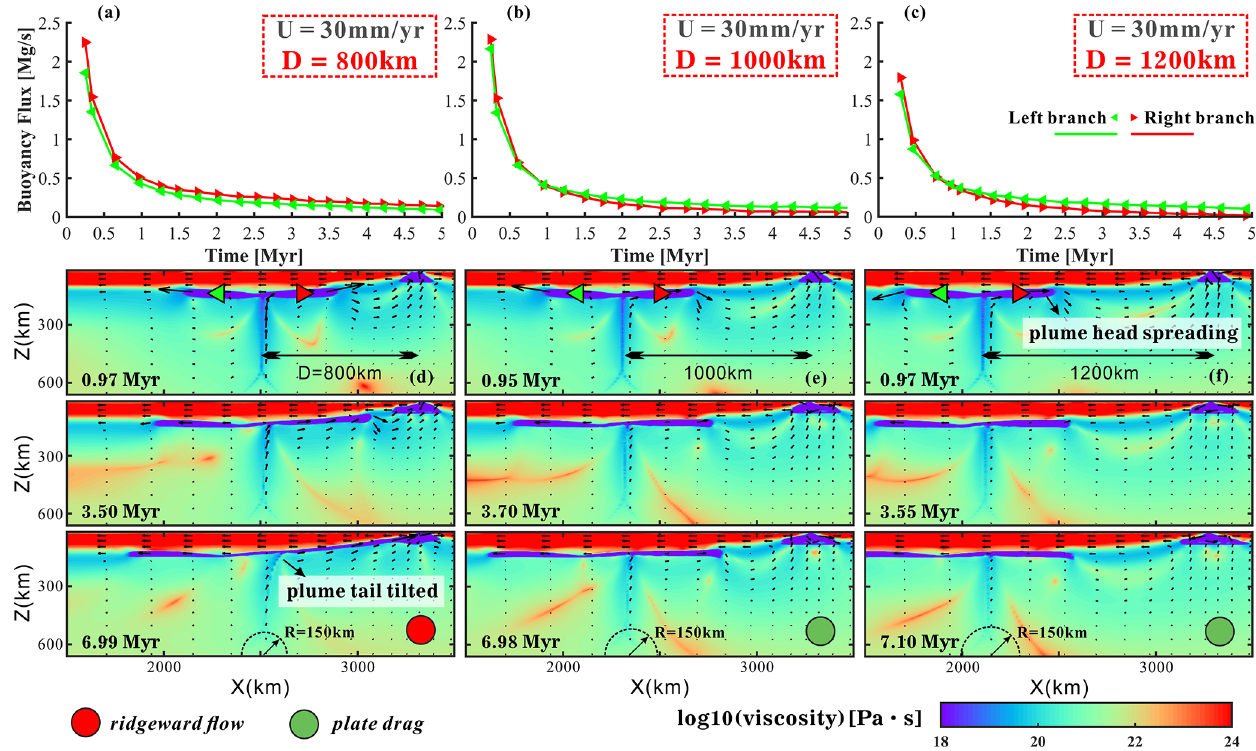
Figure 7. Models varying plume–ridge distances (model M57–M59; Table S1) shown by buoyancy flux and viscosity. (a–c) Buoyancy flux in spreading plume branches over time. Green and red triangles are markers used for buoyancy flux calculations for the left and right plume branches, respectively. U and D stand for half of the spreading rate and plume–ridge distance. (d–f) Viscosity snapshots of models with different plume–ridge distances. Models with green circles represent plate-drag plume flow, and the ridgeward plume flow is represented in